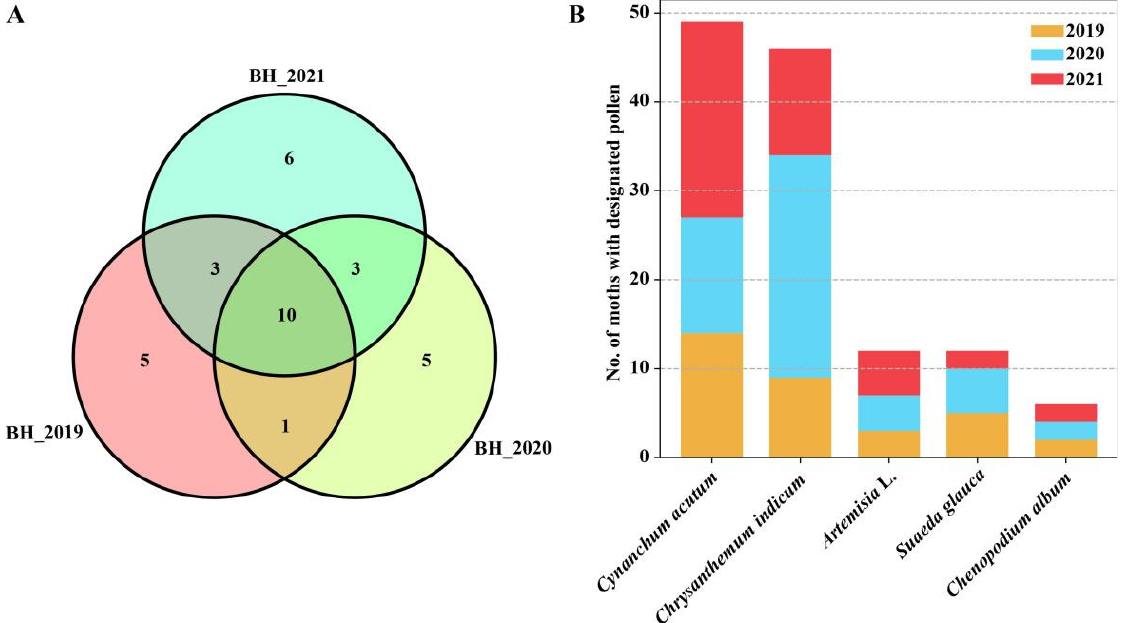
Figure 5. Annual and seasonal shifts in the pollen types found on migrant Spodoptera exigua adults sampled from Beihuang island (Bohai sea) during 2019–2021. ( A ) Venn diagram showing the common and uniquely attached pollen species in three years. The numbers in the Venn diagram indicate the number of pollen taxa identified. ( B ) Bar plot showing the number of moths contaminated with the most common pollen taxa during 2019–2021.